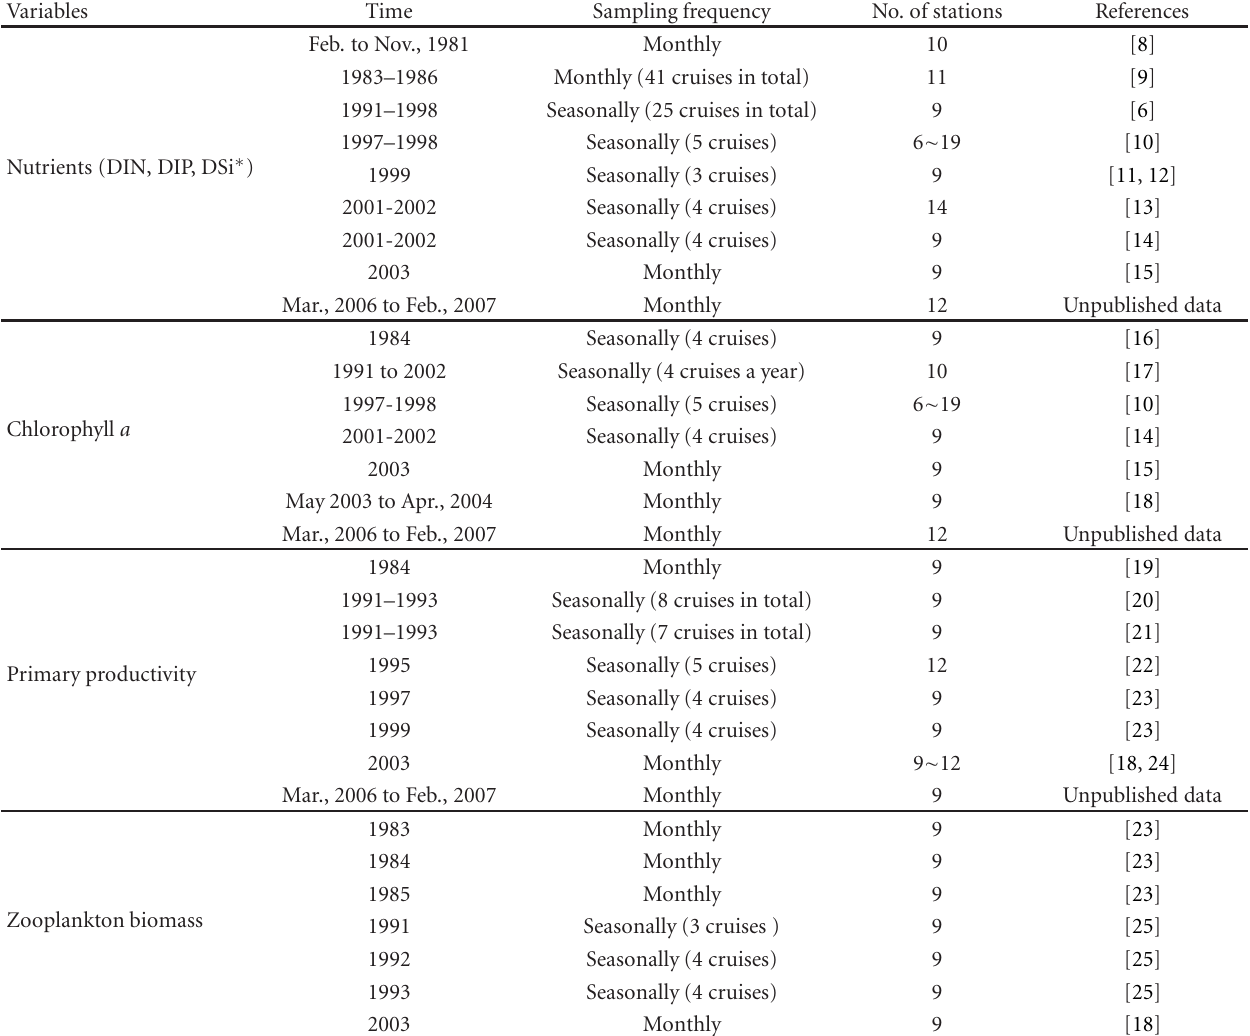
Table 1: Data sources used for nutrient and chlorophyll a concentrations, primary productivity, and zooplankton biomass in Jiaozhou